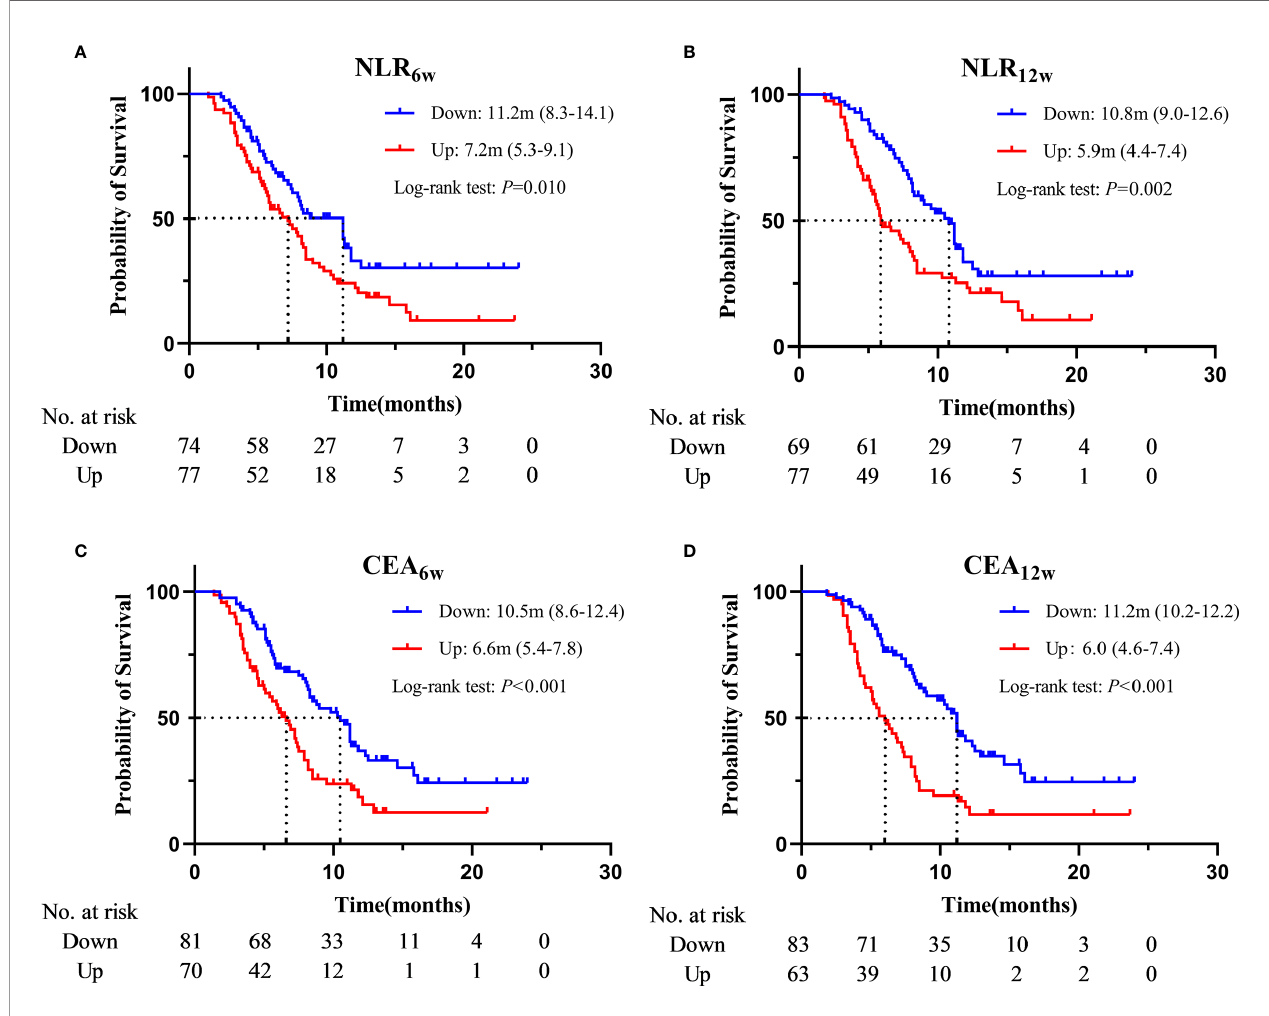
FIGURE 2 | Kaplan – Meier curves for PFS according to NLR 6w (A) , NLR 12w (B) , CEA 6w (C) and CEA 12w (D)